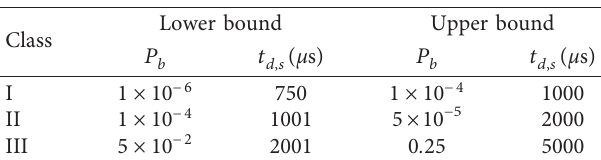
Table 2: Data sets.